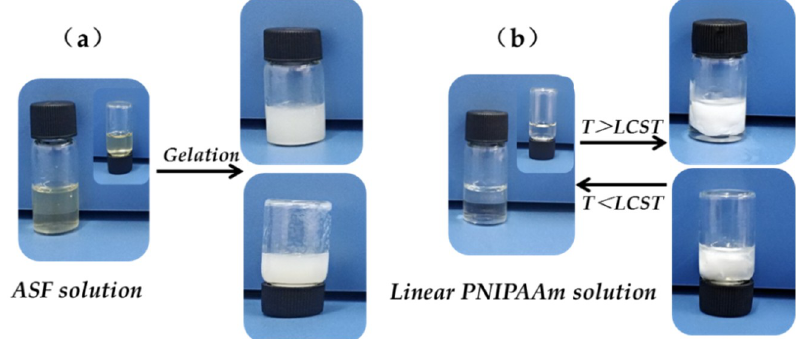
Figure 2. ( a ) Gelation behavior of ASF solution; ( b ) thermosensitive behavior of linear PNIPAAm solution.